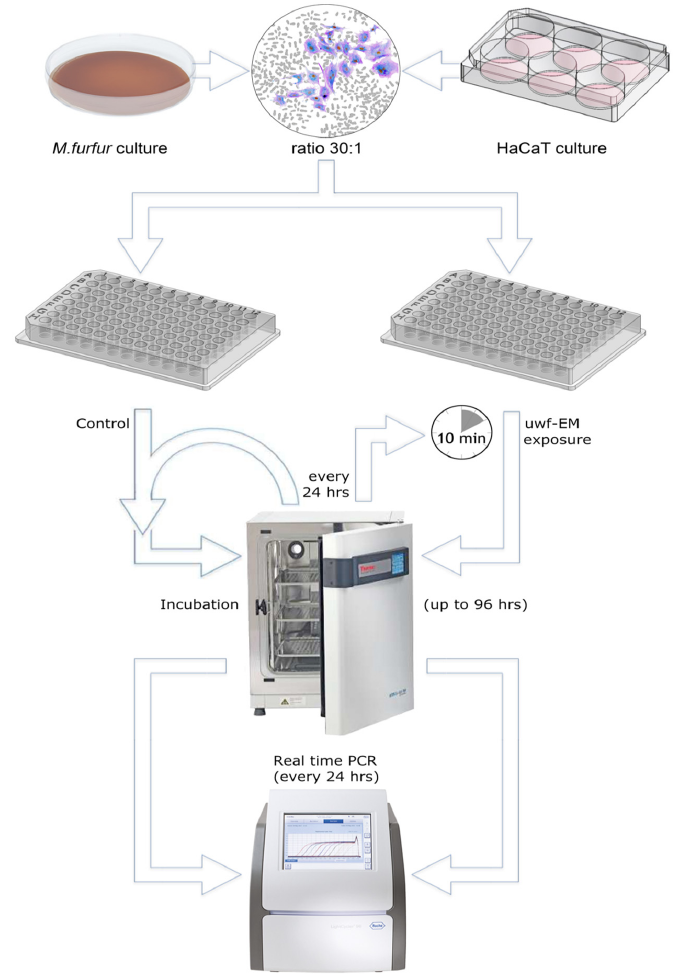
Figure 5. Simplified sketch of the performed protocol. HaCaT cells were cultivated in 6-well